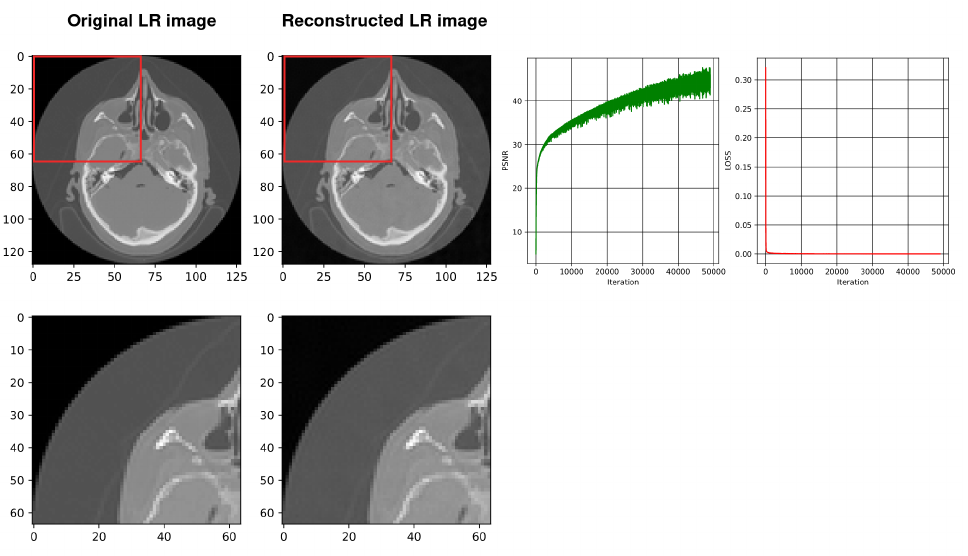
Figure 4. From left, the first image shows the original down-sampled image. The second image illustrates the reconstructed counterpart of the down-sampled image using SIREN. The next image shows the plot of the PSNR while training the network (best PSNR: 45.38) and the last image shows the plot of the loss values during the SIREN training (loss: 1.4805471 × 10 − 5 ).